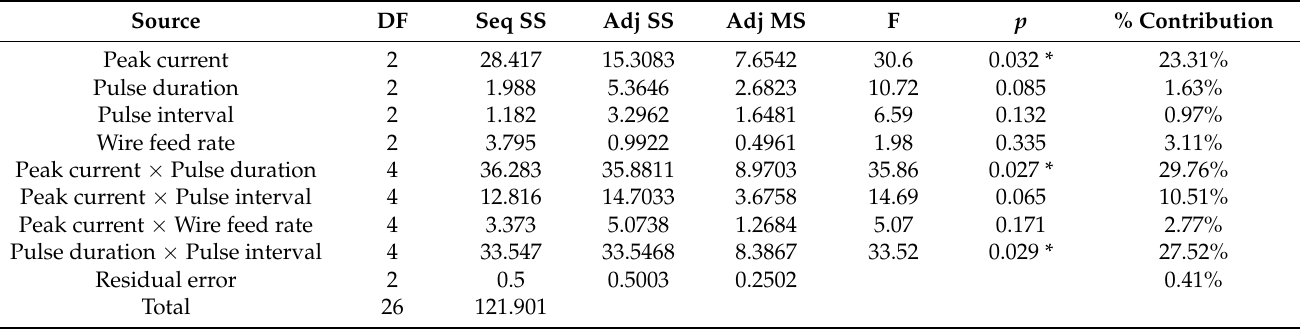
Table 5. ANOVA table for Ra. (*significant